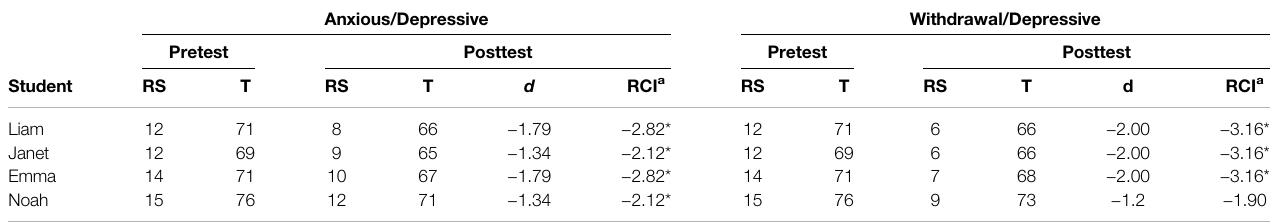
TABLE 5 | Reliable chance index for pre- posttest differences for anxious/depressive behavior and withdrawal/depressive